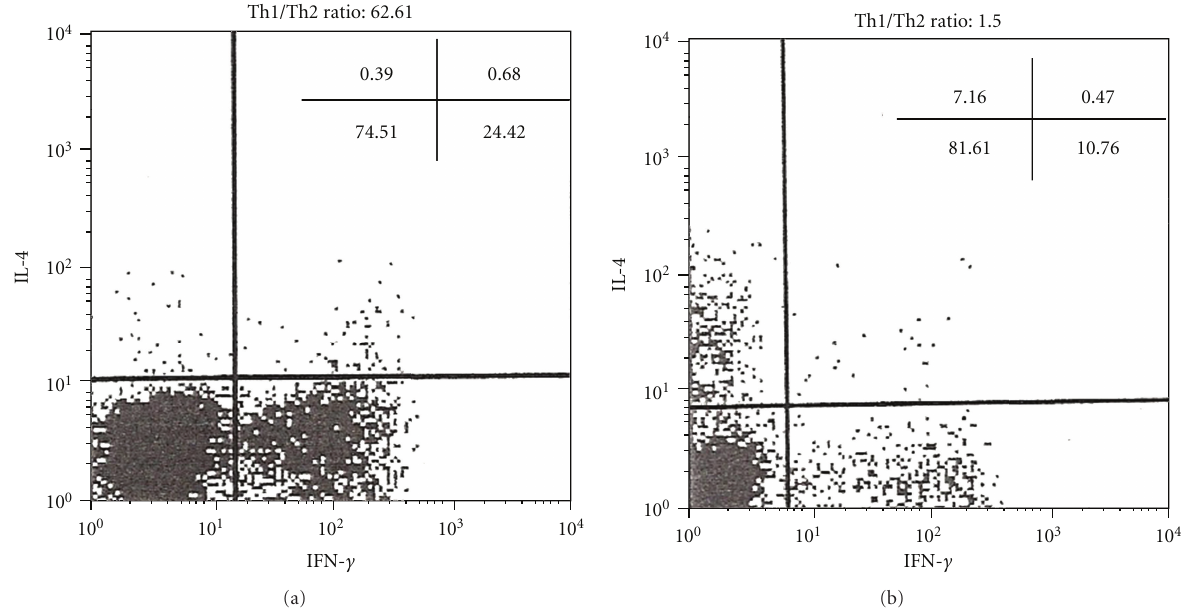
Figure 2: Representative two-color dot plots (anti-IL-4 PE versus anti-IFN- γ FITC) from analysis of intracellular cytokines by flow cytometry. Peripheral whole blood samples obtained from individuals were cultured for 4 hours with PMA and ionomycin in the presence of brefeldin A. The activated cells were fixed and stained with anti IFN- γ FITC, anti-IL-4 PE, and CD4-PerCP. The cells were then subjected to flow cytometric analysis on a FACScan flow cytometer (Becton Dickinson). Dot plots (a) and (b) are typical examples of FACS histograms which have demonstrated contrastive polarization to the Th1- and Th2-like cytokine responses, respectively. (a) histogram for one SLE patient (age/sex; 48/F) with DPLN. (b) histogram for another SLE patient (age/sex; 21/F) with MLN. The percentage of cells in each of the quadrants are shown in the right upper corners. The values of the Th1/Th2 ratio are shown in the top of each panel.